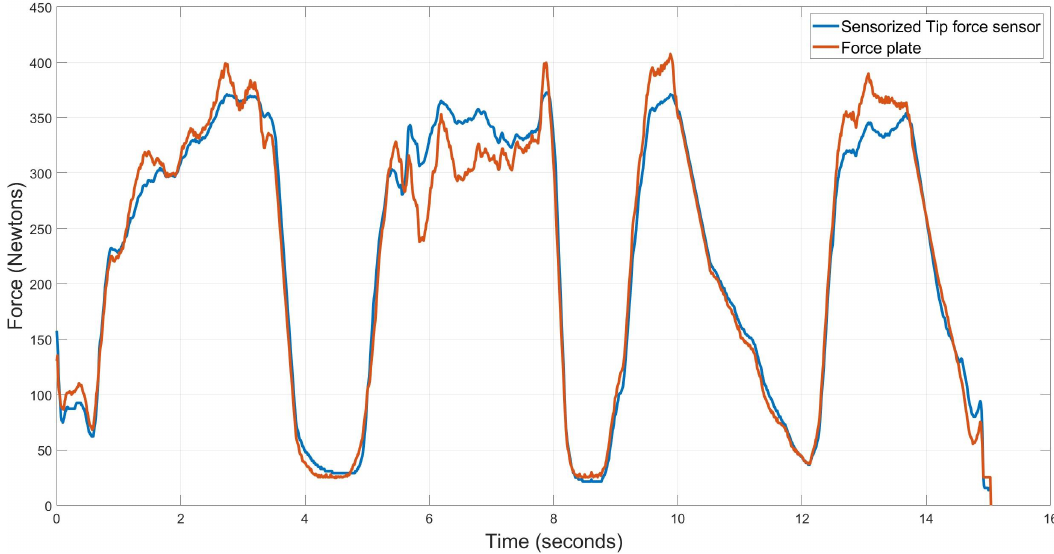
Figure 7. Force sensor after calibrate curve and data obtained from the